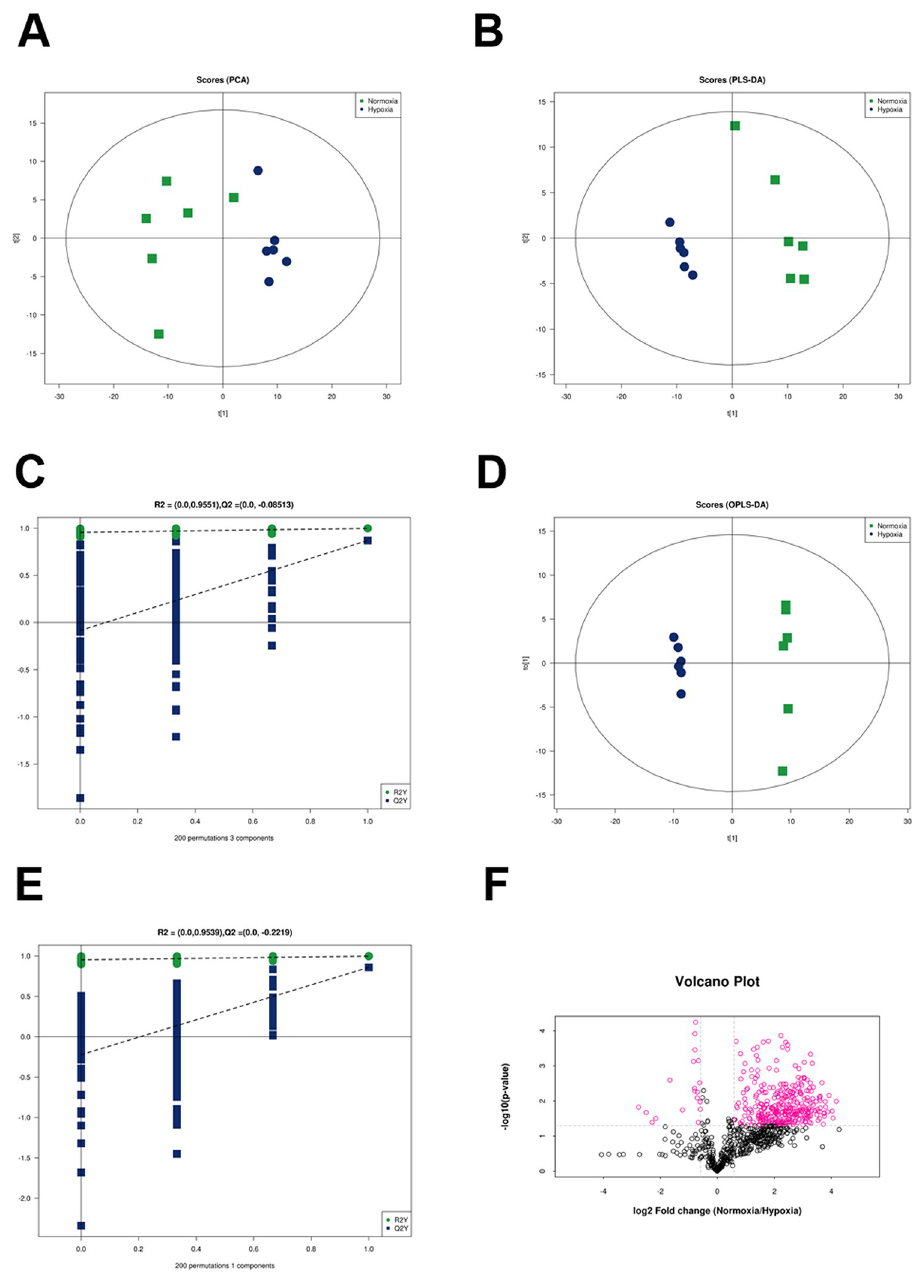
Fig 3. Univariate and multivariate analyses of lipids in rat visceral adipose tissue. (A) PCA score plot, (B) PLS-DA score plot, (C) PLS-DA permutation test, (D) OPLS-DA score plot, (E) OPLS-DA permutation test, and (F) volcano plot of the normoxia and hypoxia groups.Differences in lipid molecules with FC > 1.5 or FC < 0.67 and p-value < 0.05 are represented by different colors. The rose-red dots in the figure represent significantly different